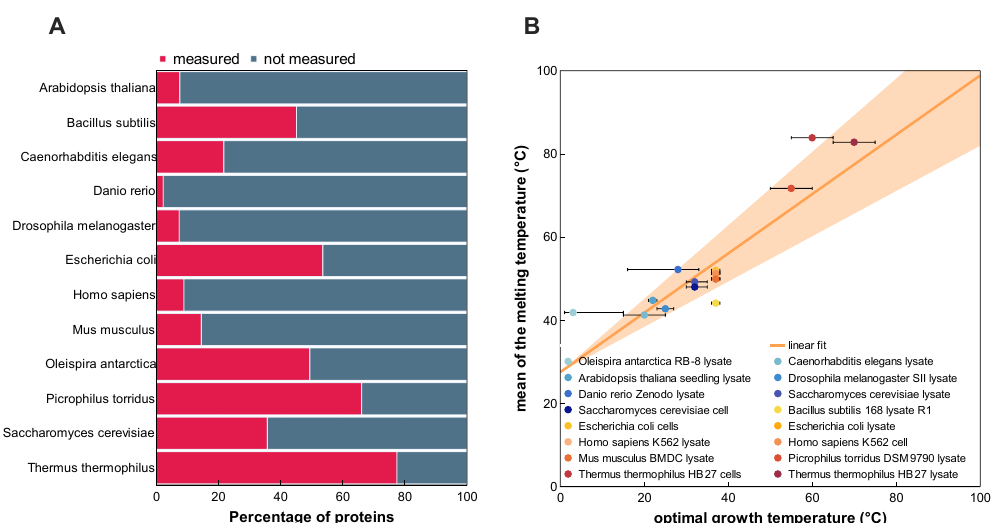
Figure 1. Melting temperature coverage ( A ) and relationship with the optimal growth temperature ( B ). ( A ) Comparison between the number of proteins measured in the meltome atlas and the number of proteins attributed to an organism according to the reference proteome. ( B ) Relationship between the melting temperature ( T m ) and the optimal growth temperature of the twelve organisms covered in the analyzed TPP datasets. Ranges of the optimal growth temperature for each organism are indicated with error bars. Marked points denote the temperatures that were used for the optimal growth temperature feature during model training and evaluation.